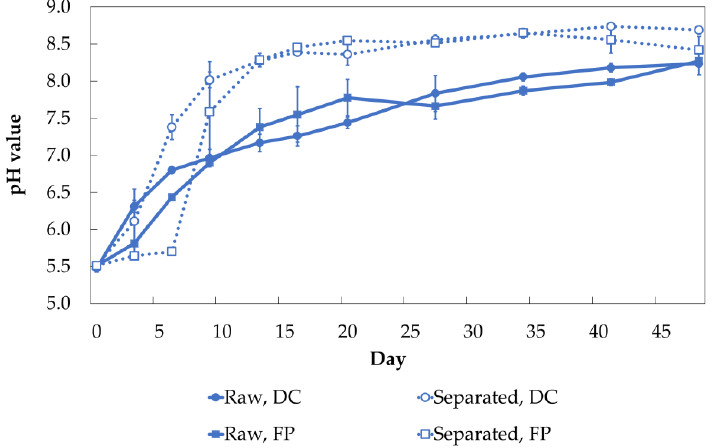
Figure 5. The pH value of dairy cow (DC, ●) and fattening slurry (FP, ▲ ) (raw and separated slurry) after acidification with sulfuric acid to a pH value of 5.5 during the storage period of 48 days (means ± SD, n = 3).